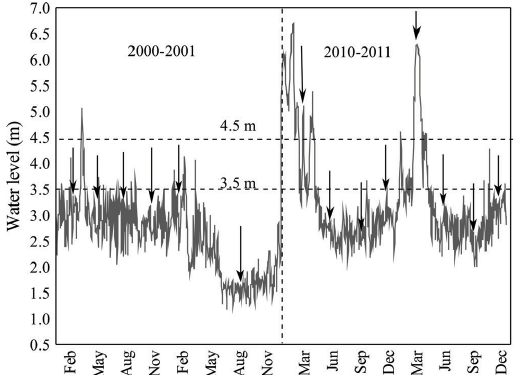
Figure 2. Variation of the water level of the Paraná River in the years of 2000, 2001, 2010 and 2011 (The arrows correspond to the sampling